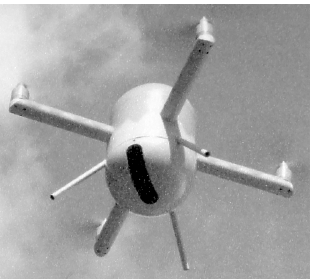
Figure 10. Comparison of a 2D photograph with a 3D image of the same heritage object (Monastery Bursfelde, Germany, photograph by Walter Schuhr)